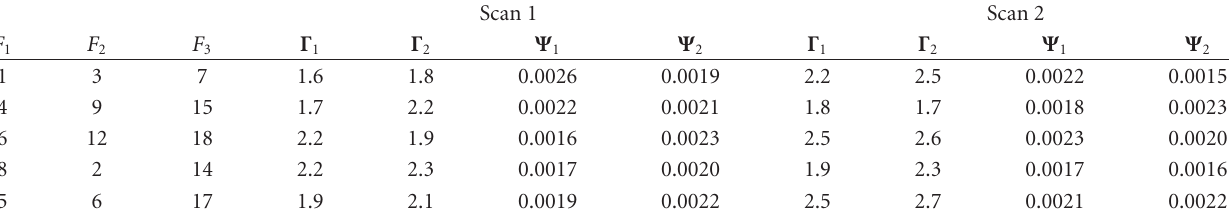
Table 5: Transitivity errors [mm] for Γ 1 , Γ 2 , Ψ 1 , and Ψ 2 are given for random frames ( F 1 , F 2 , and F 3 ) of the two cardiac cine MRI scans.